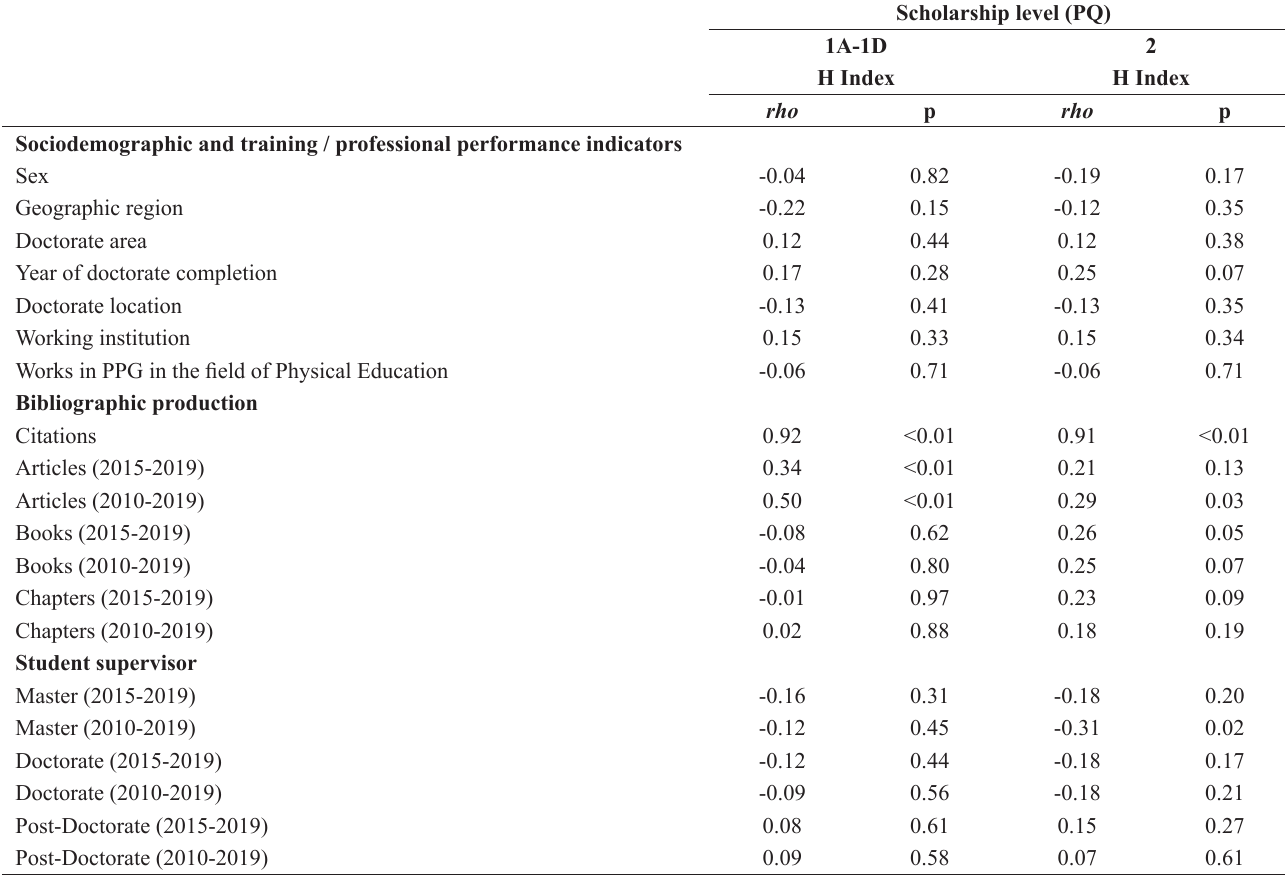
Table 4 - Correlation coefficient between H Index and sociodemographic, professional training/performance indicators, bibliographic production and guidance of CNPq Productivity Researchers in the field of Physical Education, Brazil.